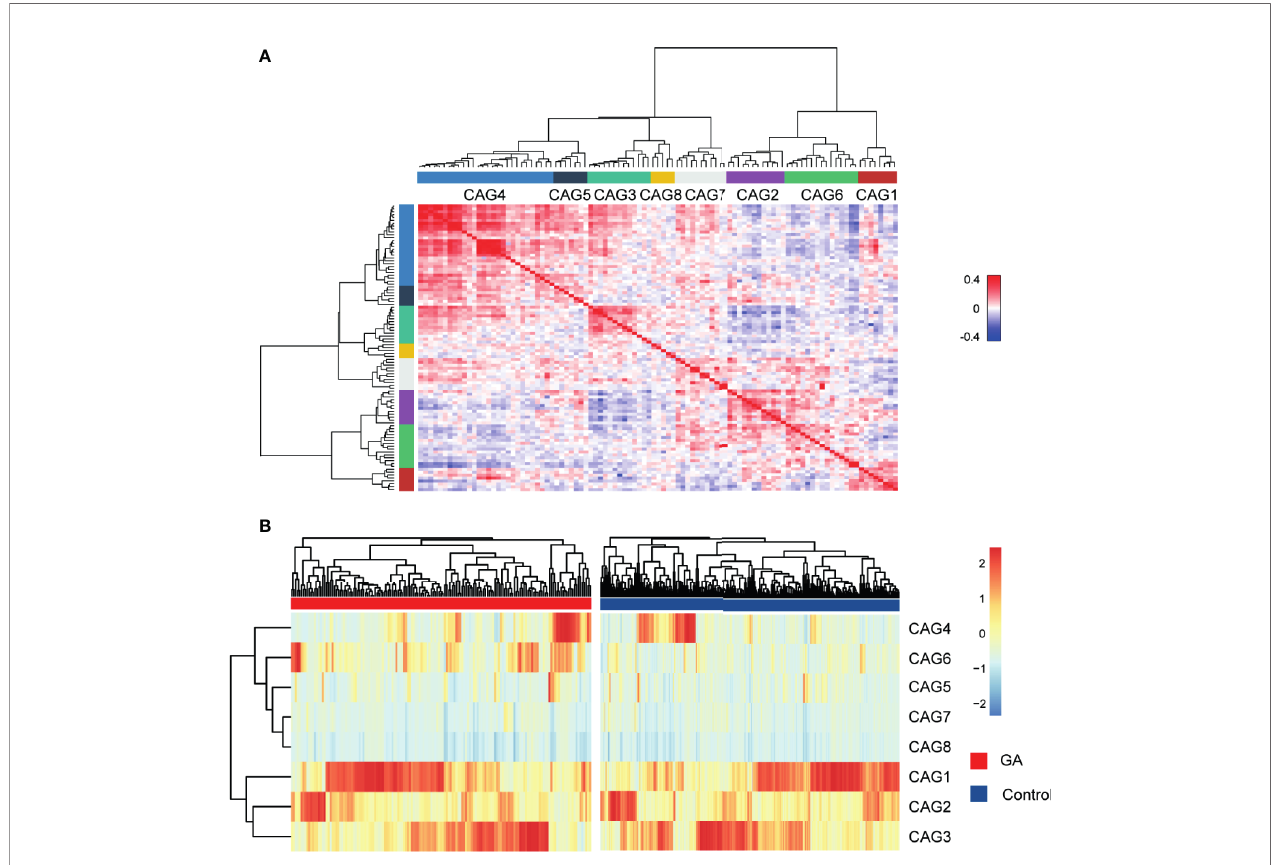
FIGURE 3 | Heatmap of microbial co-abundance group. (A) Kendall correlations coef fi cients between the top 99 most abundant genera in the second trimester were calculated, and eight CAGs were clustered based on Kendall correlation matrix. (B) CAG differently enriched in GA and healthy control in the second trimester. GA, gestational anemia; CAG, co-abundance